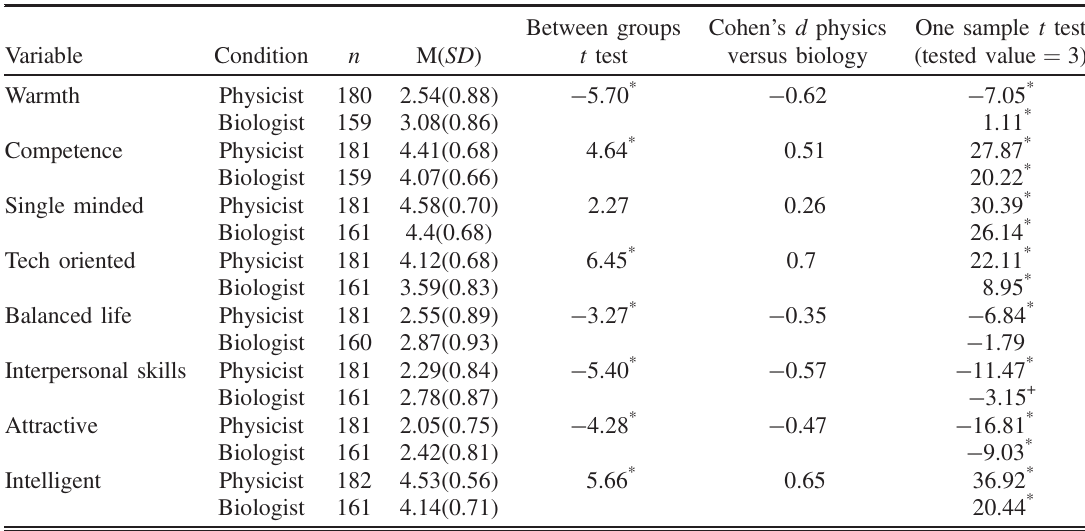
TABLE II. Descriptive statistics and t -test values for person characteristics of physicists and biologists.